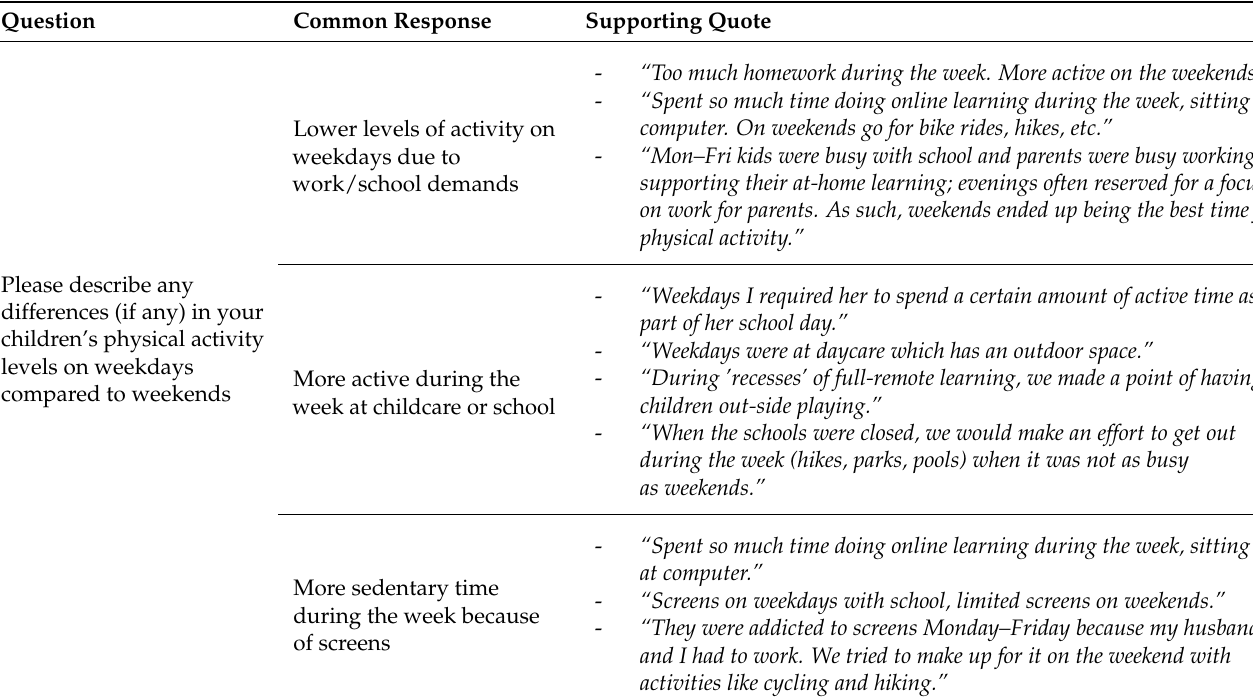
Table 3. Parents’ Open-Ended Responses Regarding their Children’s Movement Behaviors During the COVID-19 Pandemic in